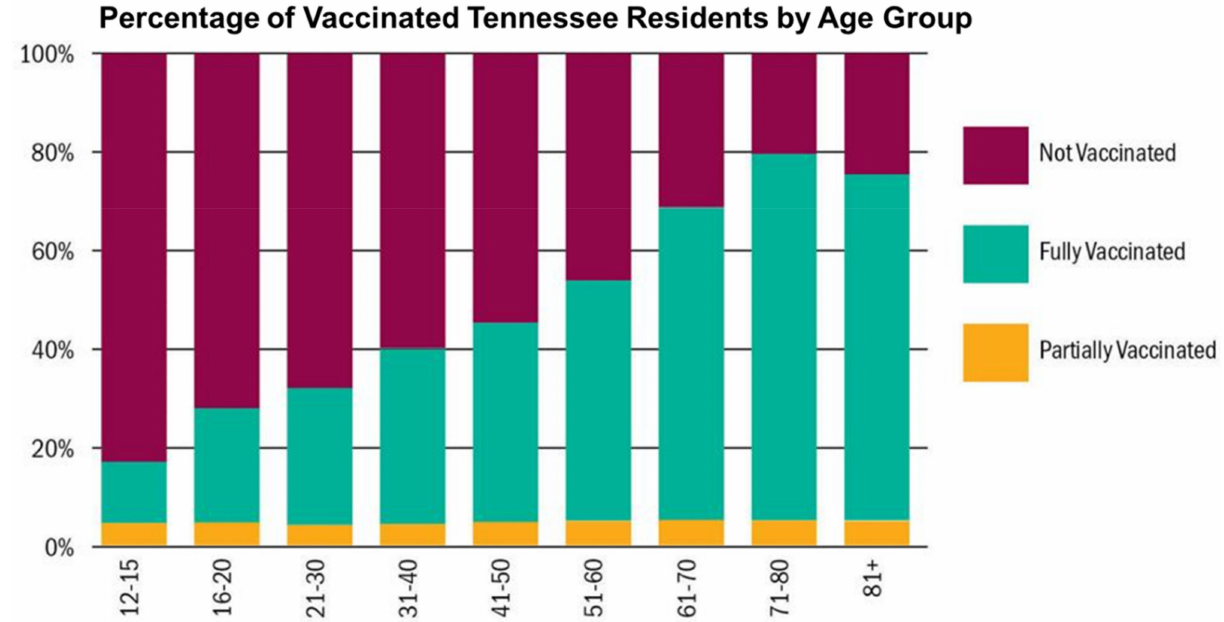
Figure 2. Percentage of Tennesseans unvaccinated, fully vaccinated, and partially vaccinated by age group as of 11 July 2021. The data shows the percentage of individuals vaccinated and unvaccinated by age. The percentage of residents who remain unvaccinated appears as red bars. The percentage of residents who are vaccinated fully appear as green bars, and those partially vaccinated appear as yellow bars (Source: Tennessee Department of Health https://www.tn.gov/health/cede p/ncov/data.html; accessed on 11 July